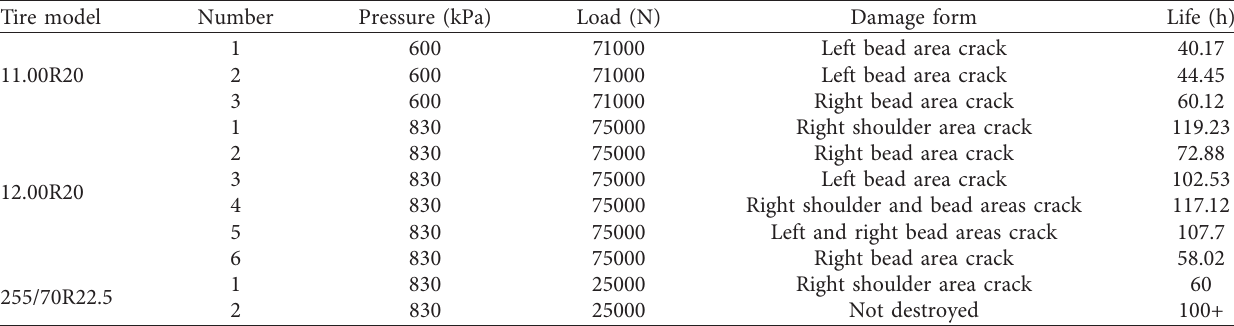
Table 1: Tire endurance test conditions and results